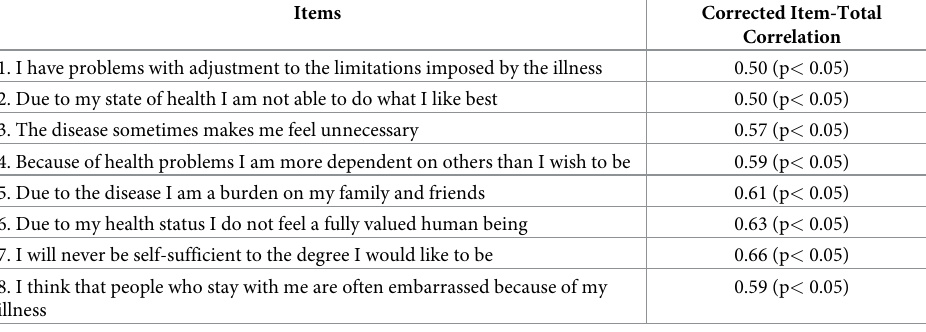
Table 4. Examination of item-total score correlations of the Acceptance of Illness Scale (N = 129). Items Corrected Item-Total Correlation